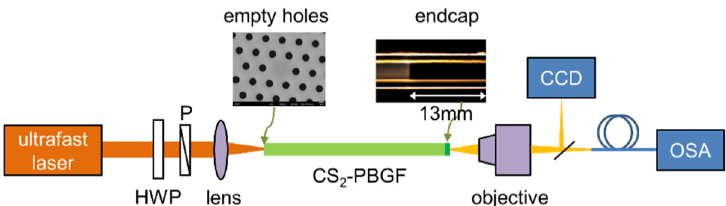
Figure 2. Sketch of the ultrafast experimental setup to characterize the supercontinuum generation process in the CS 2 -PBGF (HWP: half-wave plate; P: polarizer; OSA: optical spectrum analyzer). The left top image is the SEM picture of the used PCF without fluid inside. The right top image shows a microscopic image of the spliced endcap (the green part at the end of the CS 2 -PBGF, details in the main text).